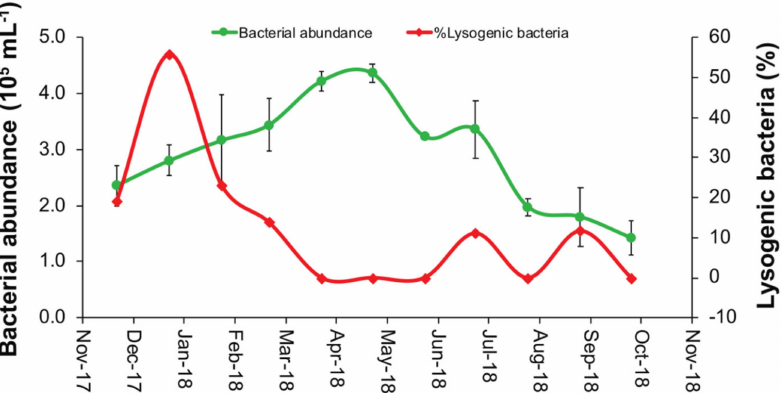
Figure 5. Percentages of lysogenic heterotrophic bacteria (red line and diamonds) and monthly mean ( ± SE) bacterial abundance (green line and dots) quantified in the natural microbial communities of the coastal Red Sea during the second year of the study (December 2017 to October